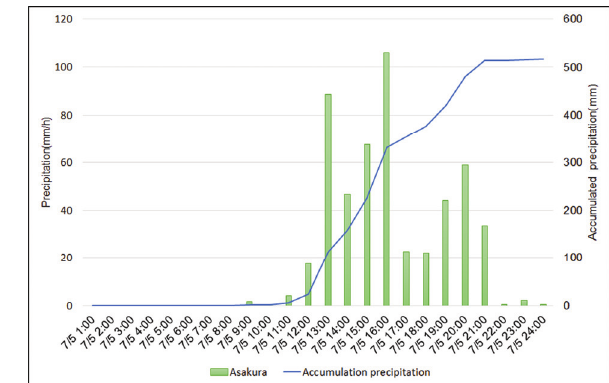
Figure 4. Accumulated precipitation at the JMA AMeDAS Asakura station.